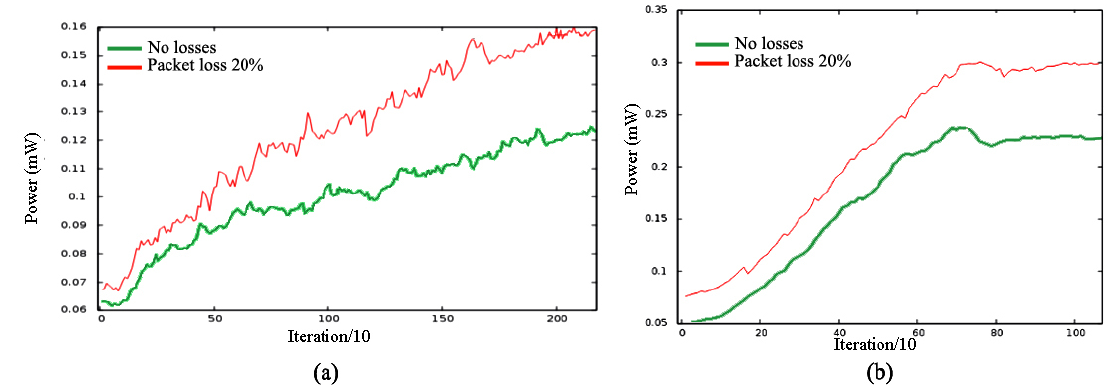
Figure 3. ¯ P during deployment: ( a ) BDA; ( b )